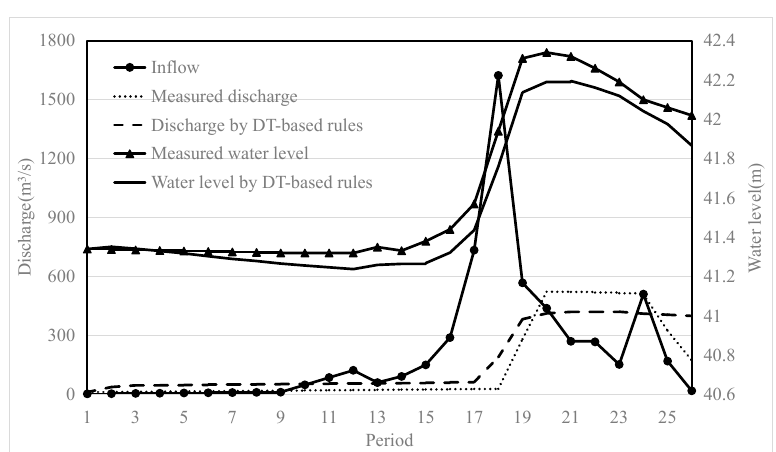
Figure 4. Operation hydrographs for 22 July